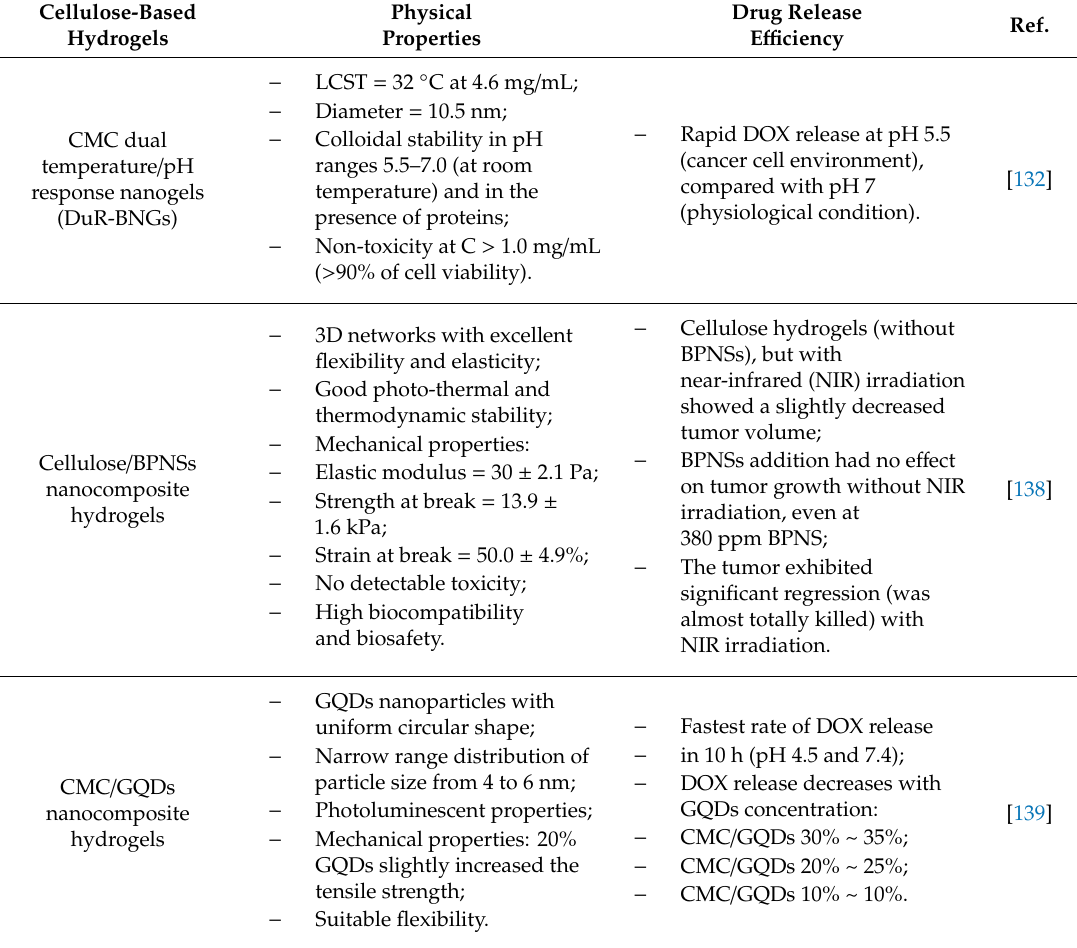
Table 3. Physical properties of cellulose-based hydrogels and their drug-release e ffi ciency as delivery systems in cancer